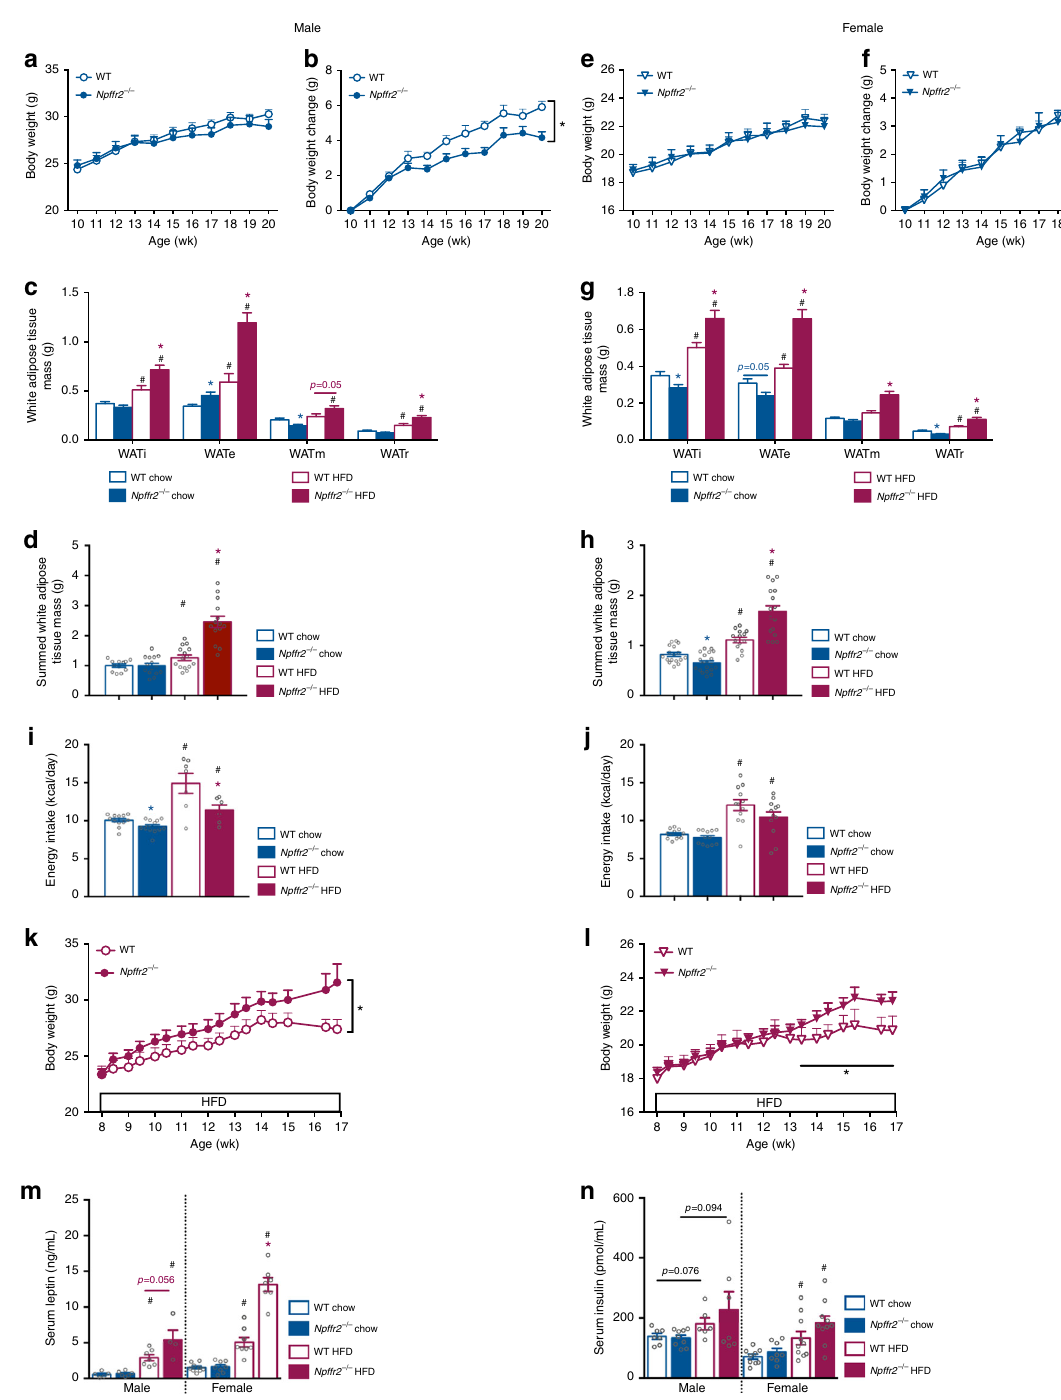
Fig. 2 Exacerbated diet-induced obesity in Npffr2 − / − mice. a , b , e , f Growth curve and body weight gain of mice on chow. Male: WT (open circle) n = 12, Npffr2 − / − ( fi lled circle) n = 8. Female: WT n = 11, Npffr2 − / − n = 9. c , g Weights of individually dissected white adipose tissue depots of mice on chow or HFD. WATi, WATe, WATm and WATr represent inguinal, epididymal, mesenteric and retroperitoneal white adipose tissue, respectively. Male chow: WT n = 12, Npffr2 − / − n = 15. Male HFD: WT n = 15, Npffr2 − / − n = 14. Female chow: WT n = 17, Npffr2 − / − n = 20. Female HFD: WT n = 14, Npffr2 − / − n = 16. d , h Weights of summed white adipose tissue depots shown in c , g , respectively. i , j Energy intake in mice on chow or HFD. Male chow: WT n = 12, Npffr2 − / − n = 13; male HFD: WT n = 7, Npffr2 − / − n = 6. Female n = 12 per group. k , l Body weight curve on HFD. Male WT n = 13, Npffr2 − / − n = 14. Female: WT n = 8, Npffr2 − / − n = 10. m , n Serum leptin and insulin levels. Leptin: male chow (WT n = 5, Npffr2 − / − n = 6), HFD (WT n = 7, Npffr2 − / − n = 4); female chow (WT n = 7, Npffr2 − / − n = 8), HFD (WT n = 8, Npffr2 − / − n = 7); insulin: male chow (WT n = 7, Npffr2 − / − n = 9), HFD (WT n = 6, Npffr2 − / − n = 7); female chow (WT n = 9, Npffr2 − / − n = 8), HFD (WT n = 10, Npffr2 − / − n = 10). Tissues and serum samples were collected at 20 weeks of age for the chow cohort and at 17 weeks of age for the HFD cohort after 9 weeks of HFD. Data are mean ± SEM. One-way ANOVA ( c , d , g , h , i , j , m , n ) or repeated measures ( a , b , e , f , k , l ) were used to determine genotype or diet effects among groups. ∗ p < 0.05 vs. WT of the same diet. # p < 0.05 vs. chow group of the same